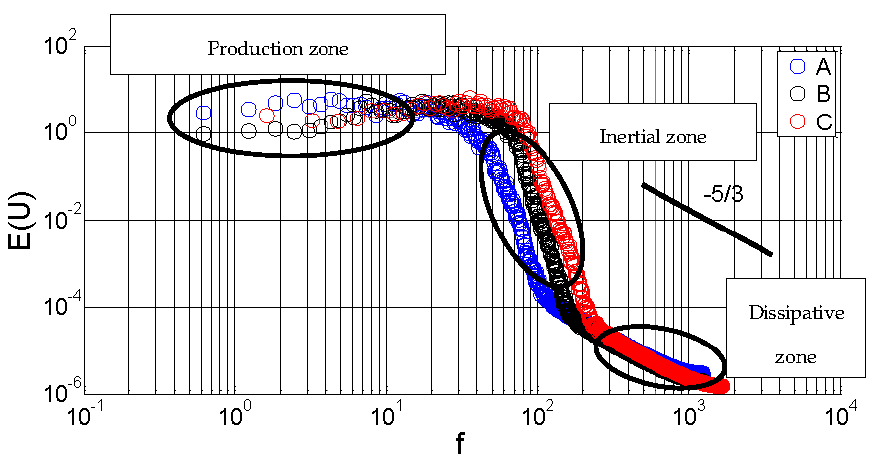
Figure 13. Spectral analysis obtained for different values of N . The first zone is the zone at large scales, where turbulence production takes